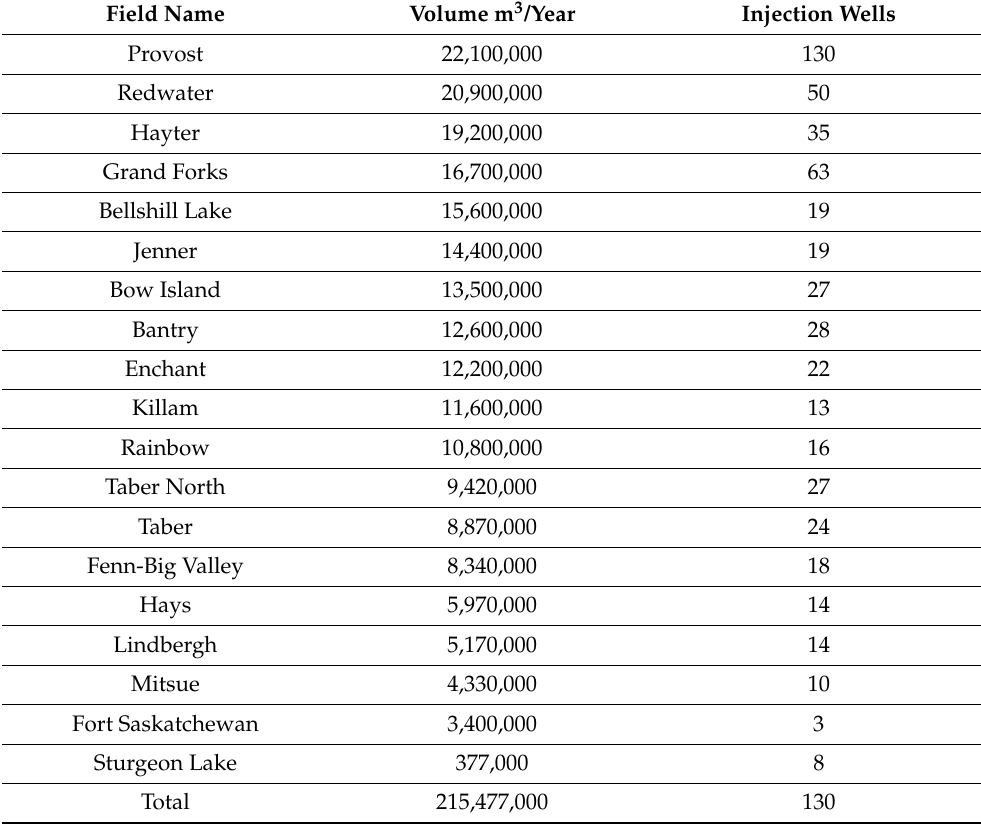
Table 2. Top 10 Largest Injection Fields, Injection Volumes and Number of Injection Wells in Alberta, Canada, in 2006 (modified from